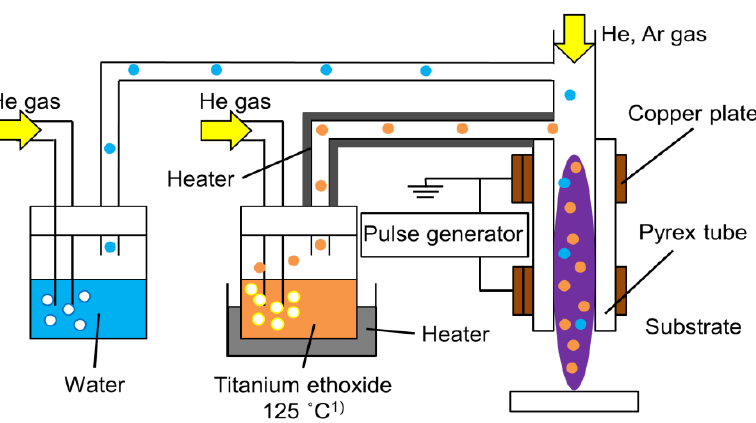
Figure 8. Schematic diagram of experimental setup used for the synthesis of TiO 2 thin films using atmospheric pressure plasma jet.